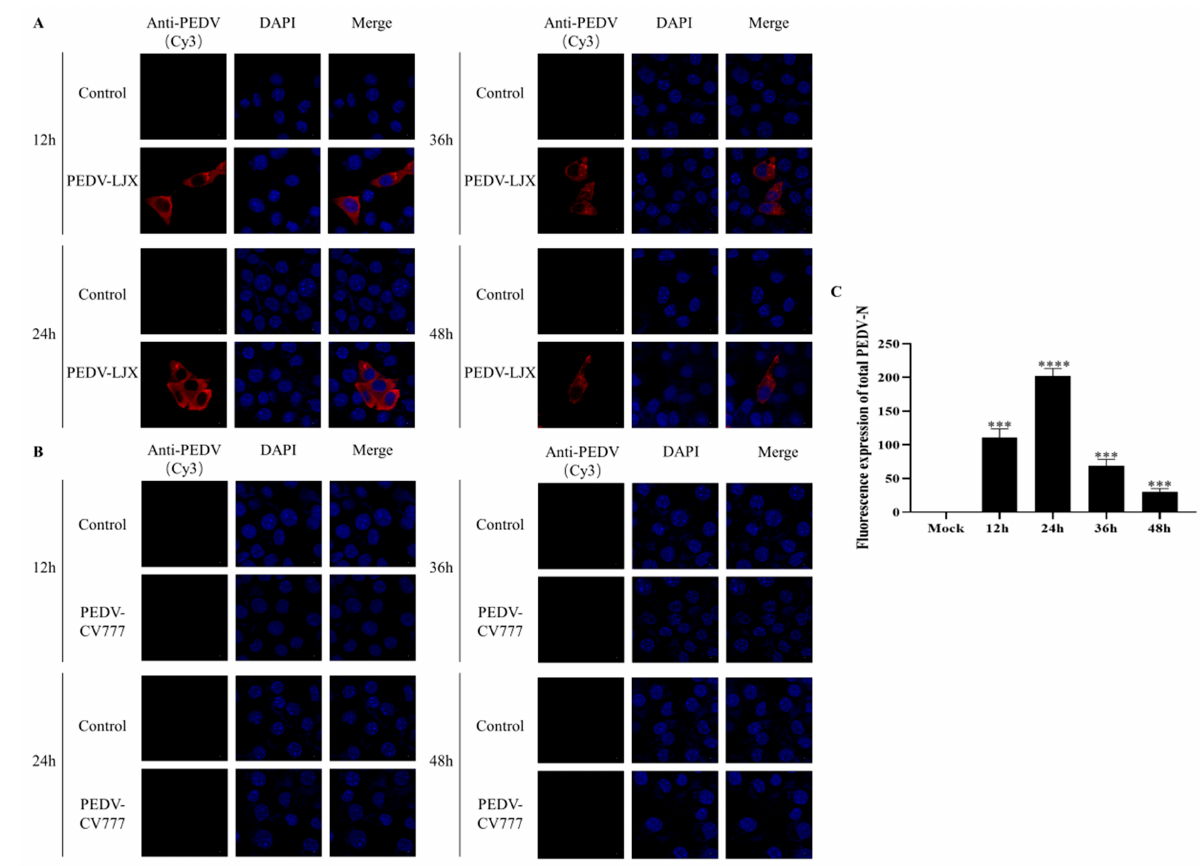
Figure 2. ( A ) Immunofluorescence results of PEDV-LJX infection of FHs 74 Int cells (Cy3: PEDV N protein, DAPI: nucleus). ( B ) Immunofluorescence results of PEDV-CV777 strain infection with FHs 74 Int cells. ( C ) Quantitative analysis of immunofluorescence for the PEDV-N protein after infection with PEDV-LJX. Cy3, cyanine 3; DAPI, 4 ′ ,6-diamidino-2-phenylindole. (*** p -value < 0.001; **** p -value < 0.0001)